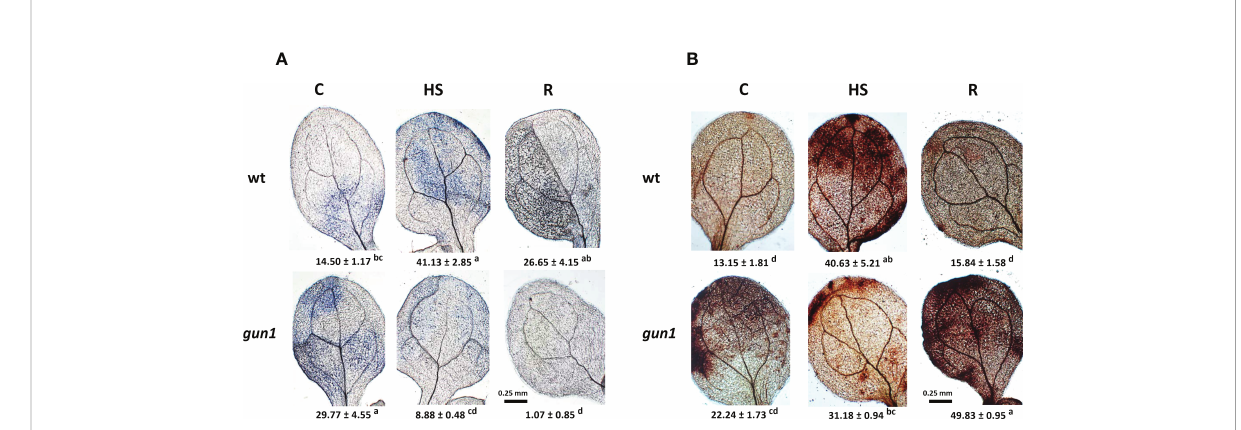
FIGURE 4 Accumulation of superoxide anion (O 2 − ) and hydrogen peroxide (H 2 O 2 ) in 15 days-old wt and gun1 plantlets, grown at control temperature (C) or subjected to Heat Stress (HS; 2 hours at 45°C), followed by short recovery (R; 3 hours at 22°C). Representative images of (A) O 2 − accumulation, visualized by nitroblue tetrazolium (NBT)-staining and (B) H 2 O 2 accumulation, visualized by diaminobenzidine (DAB)-staining. O 2 − and H 2 O 2 analyses were repeated three times showing reproducible results. The percentage area ( ± SE) of 60 leaves (20 for each experiment) stained with NBT and DAB, respectively, are indicated. Letters indicate signi fi cant differences obtained by one-way ANOVA test (P<